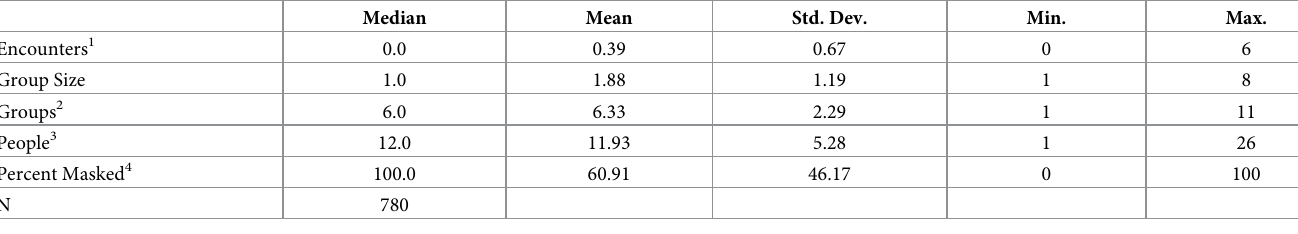
The average number of people observed during the one-minute interval was 11.93 and ran- ged from 1 to 26. The distrubution of people is shown in Fig 7. Mask wearing showed a split among visitors in that 61 percent of observed individuals were wearing masks. Within groups there was a distinct split with nearly everyone wearing a mask or no one wearing a mask. In Fig 8 we categorize groups by the proportion of members wear- ing masks. Thirty-four percent of groups had no members wearing a mask while 55 percent of groups had everyone wearing a mask. Eleven percent of groups had some, but not everyone, wearing a mask. In the analysis, we include the percent of people observed wearing a mask in the group.